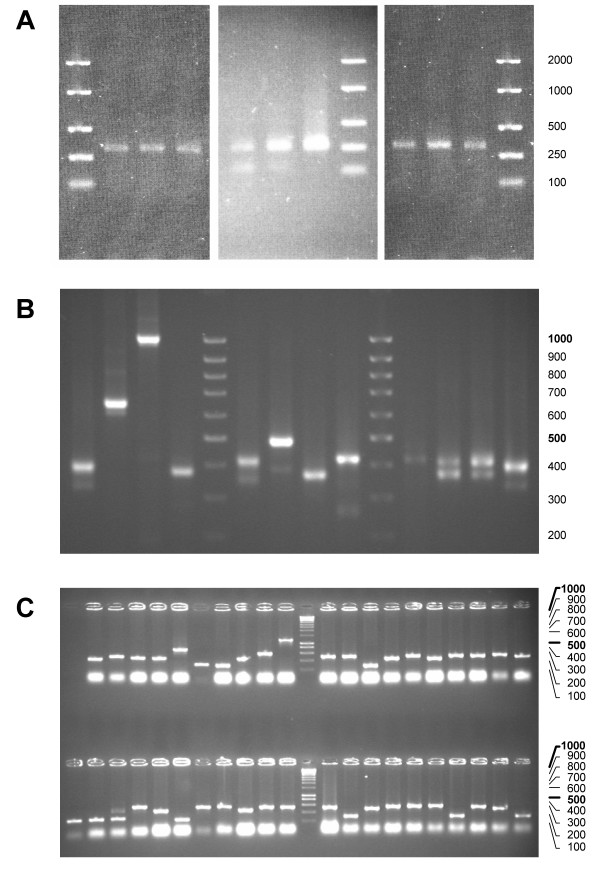
PCR using the designed primers. (A) The optimisation of the annealing temperatures. Each hybrid primer was tested for amplification at three different annealing temperatures, roughly chosen as Tm-7°C, Tm-5°C and Tm-3°C (based on Tm values calculated using on-line primer design software from Sigma-Genosys). Hybrid primer M22F (panel A, left gel) does not show any preference for annealing temperature. Primer M15F (panel A, middle) shows strong preference for Tm-7°C. Primer 06F (panel A, right panel) exemplifies an apparent preference for Tm-5°C. Note, although all the above amplifications were performed simultaneously under identical conditions and using gradient PCR machine, no quantitative estimate of the amplification efficiencies can be made. However, relative differences due to the change of the annealing temperature could and have been detected. (B) A gel electrophoresis exemlifying RACE-PCR amplification of Agelena orientalis cDNA using hybrid primers (left to right) M31F, M33F, M35F, M37F, M39F, M41F, M43F, M45F, M47F, M49F, M51F, M31F (identical to the leftmost PCR product). Nearly all primers (except for M37F and M47F) yielded more than one group of products. Amplification conditions were optimised for each hybrid primer, as described above (panel A) and the oligo-dT primer with the matching Tm (see Table 1). (C) High throughput positive clone selection by direct PCR amplification from bacterial colonies. The lower band (just above 100 bp marker) corresponds to amplified plasmid fragments without inserts. The upper bands are the amplified fragments with inserts. Plasmid specific primers PBS-F and PGM-2R were used (see Table 1 for sequences).